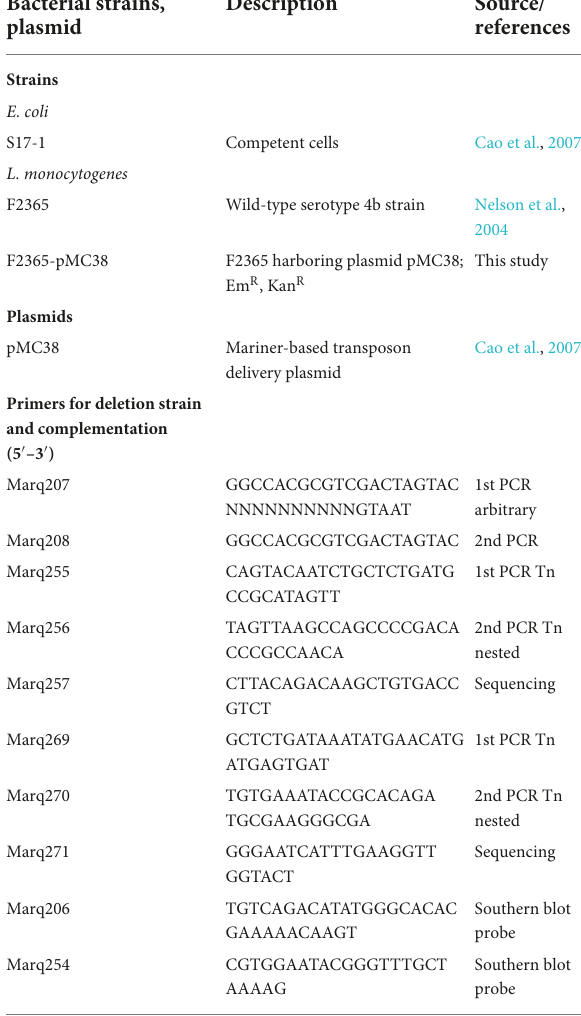
TABLE 1 Bacterial strains and plasmids used for this study. Bacterial strains,